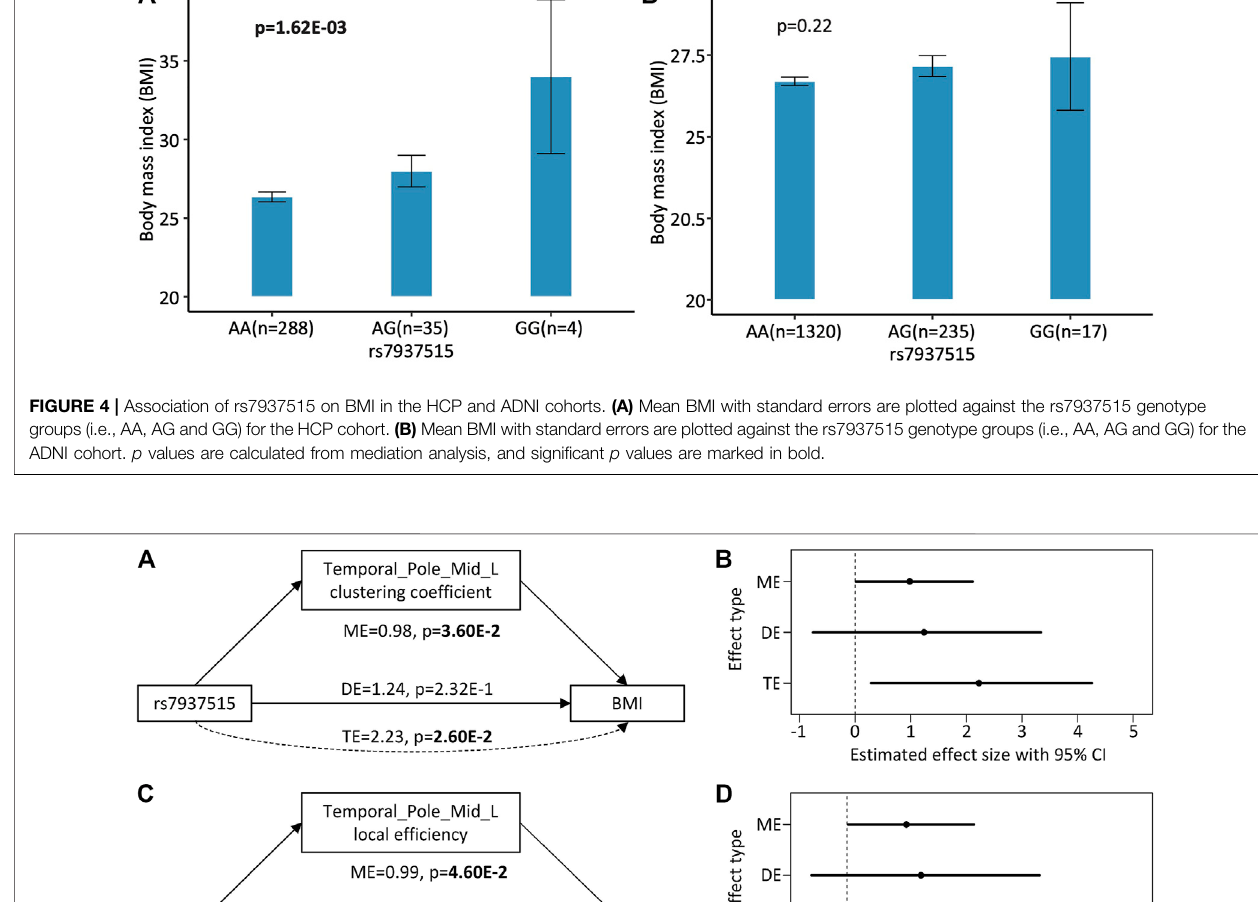
Frontiers in Genetics |